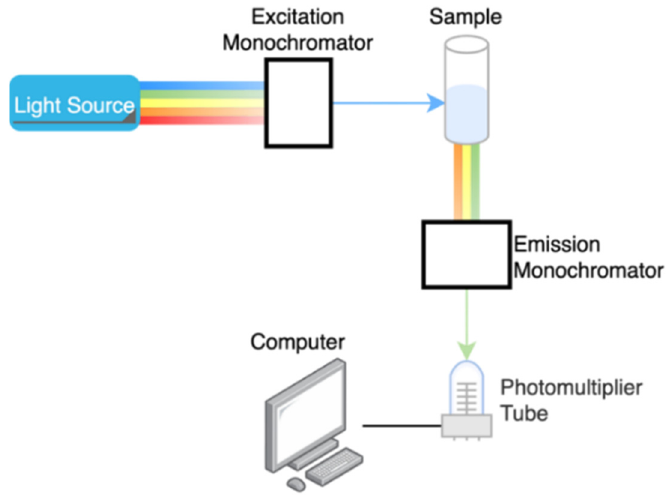
Figure 11. Schematic diagram of fluorescent spectroscopy.